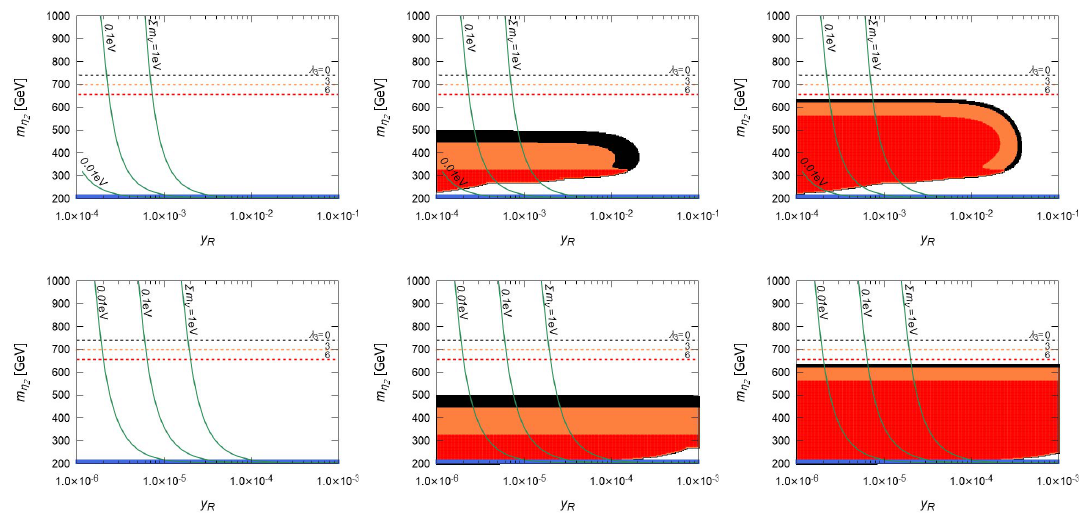
Figure 5 . Constraints on the parameter space in the y 200 GeV, θ = π/ 4 and λ 2 , 6 , 7 , 8 = 0 . We take M R = 100 MeV (upper plots) and 190 GeV (lower plots). The efficiency factor (cid:15) is taken to be 3% (left), 30% (center) and 100% (right), where the result with (cid:15) = 0 . 3% (value obtained by naive estimation) is the same as that with (cid:15) = 3% . The regions above the black, orange and red dashed lines are excluded by the perturbative unitarity bound, while the areas shaded in black, orange and red are excluded by the LHC data for λ 3 = 0 , 3 and 6, respectively. The region shaded in blue is excluded by the perturbativity bound ( f µ green contour shows the sum of the neutrino masses P